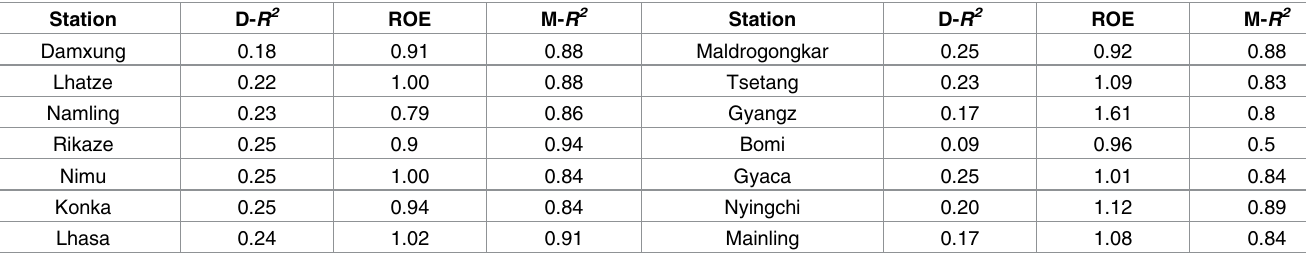
Table 1. Validation of TRMM precipitation at daily and monthly time